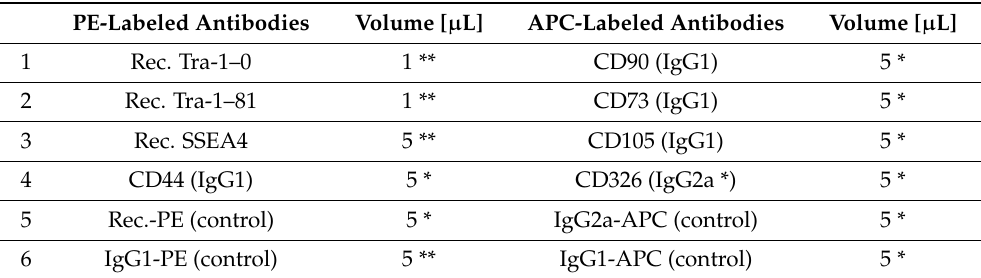
Table 1. List of the antibodies used for the detection of MSC and iPSC marker expression on iMSCs; * Biolegend, ** Miltenyi. Rec-recombinant.